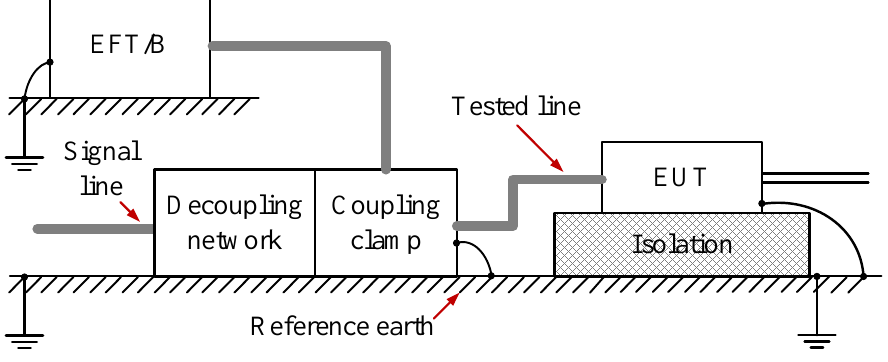
Figure 4. Test setup of the EFT/B according to IEC 61000-4-4.